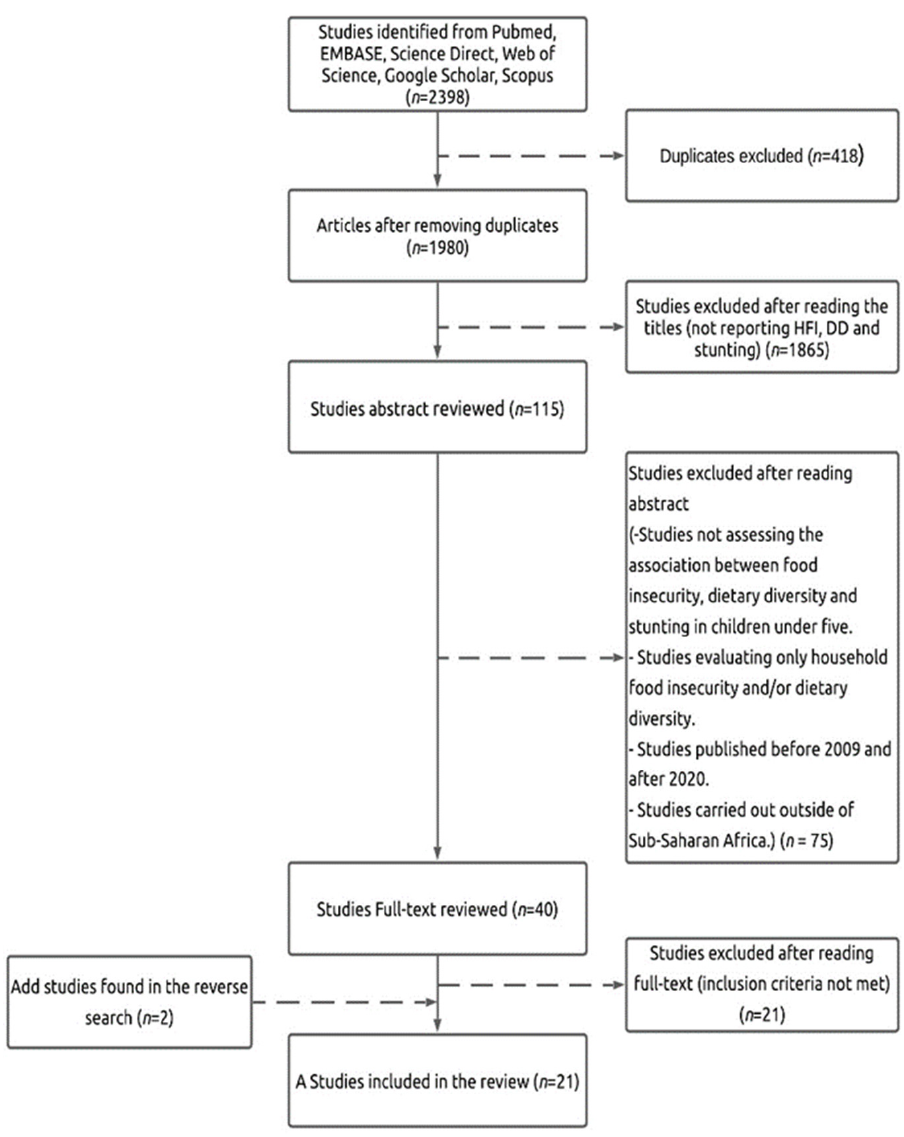
Figure 1. Flowchart for the selection of studies based on the PRISMA 2015 guidelines.